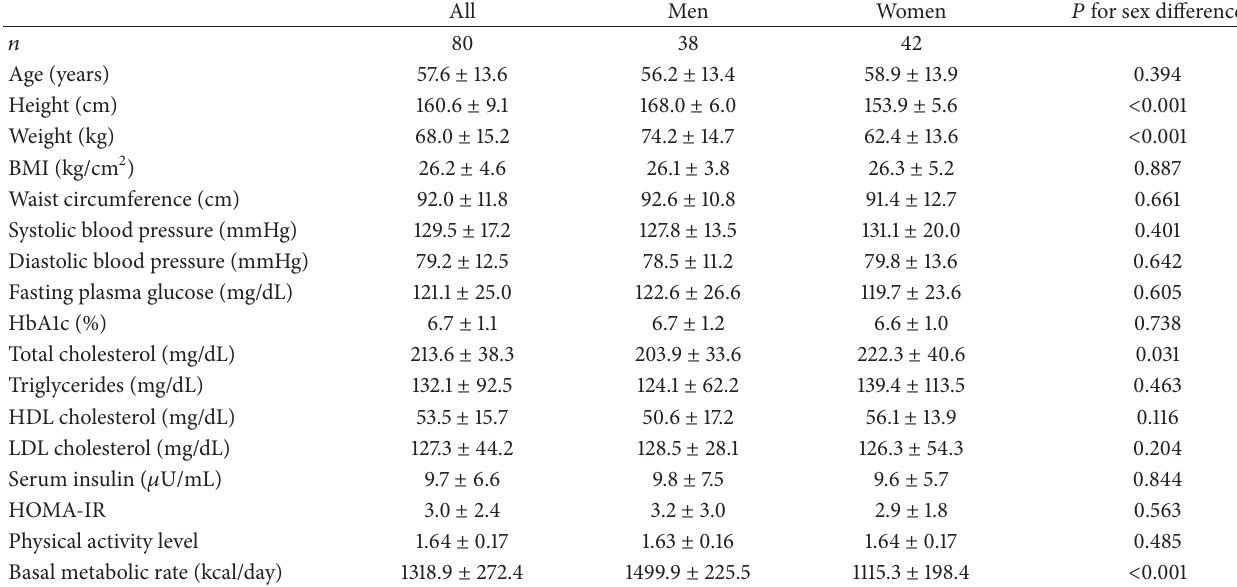
Table 1: Physical and biochemical characteristics of the subjects.